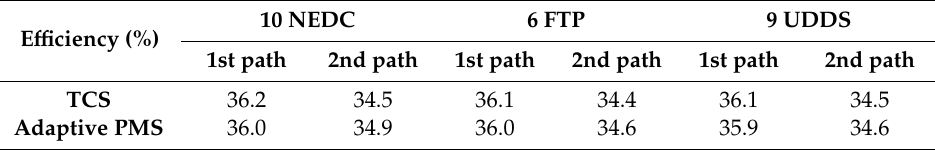
Table 10. Energy usage e ffi ciency of the genset in the 1st path and 2nd path.